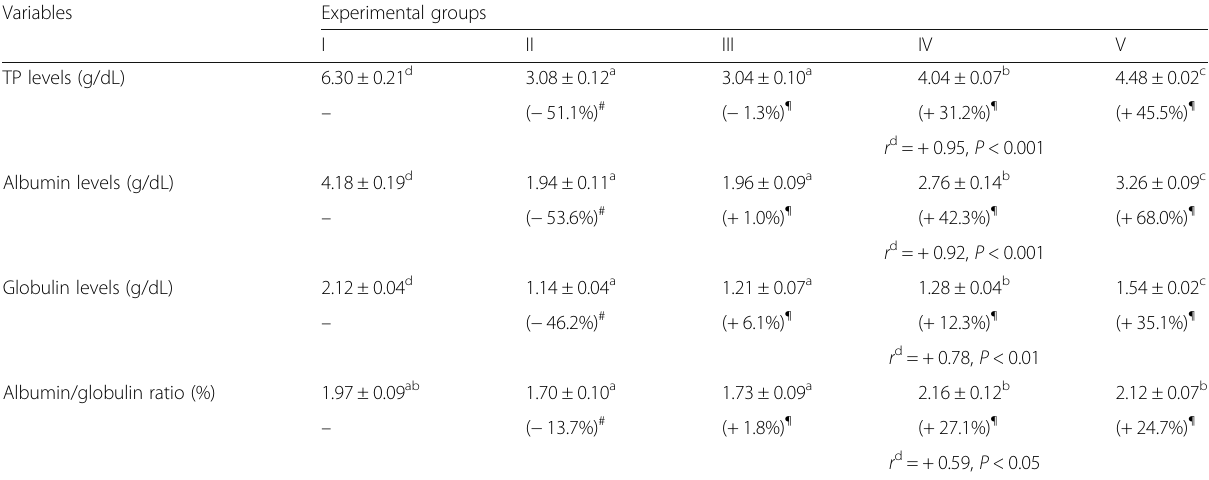
Table 5 The levels of total proteins (TP), albumin, globulin, and albumin/globulin ratio in the serum of all the experimental groups, at the end of the experiments